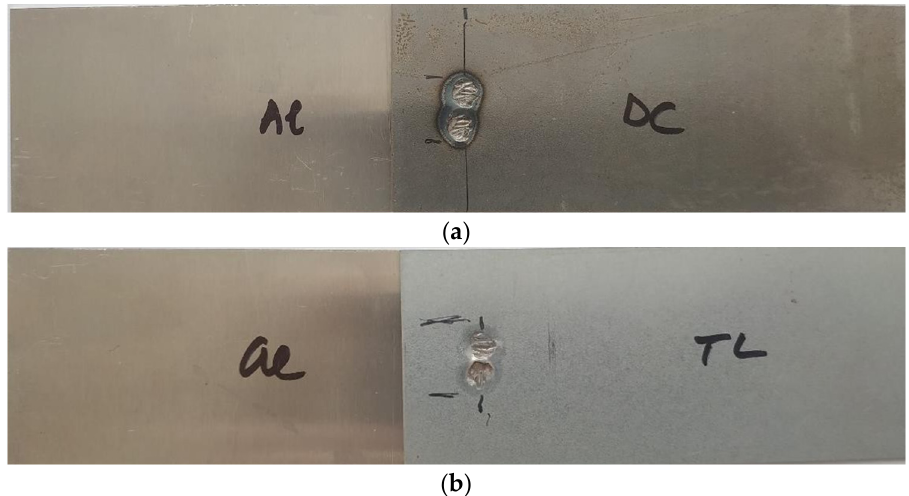
Figure 6. Appearance of test joints made by resistance spot welding: ( a ) Al-DC and ( b ) Al-TL.